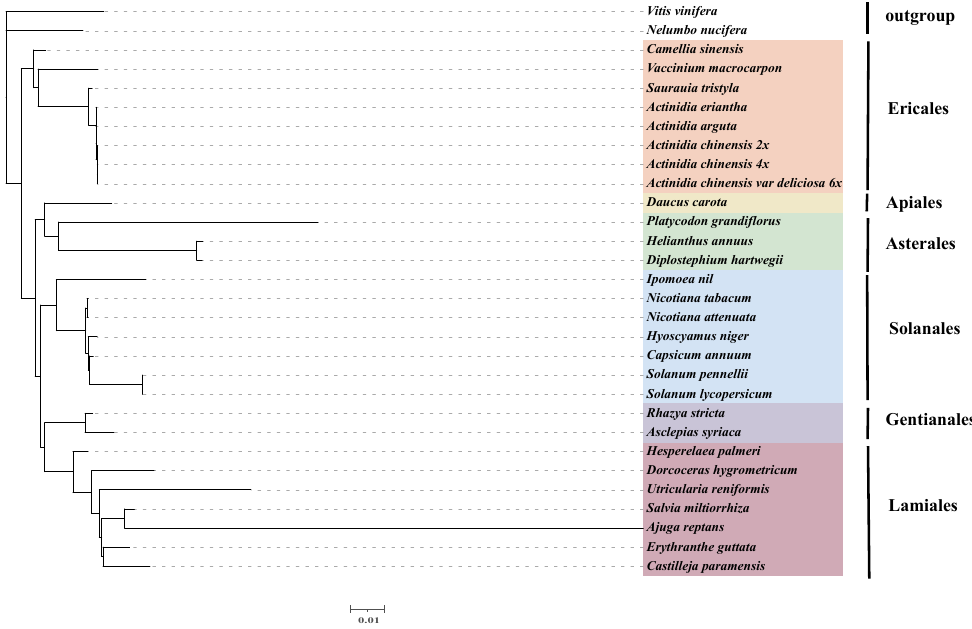
Figure 7. Maximum likelihood phylogenetic tree analysis of Actinidiaceae mitogenomes based on 20 PCGs of 23 plant mitogenomes with V. vinifera and N. nucifera as